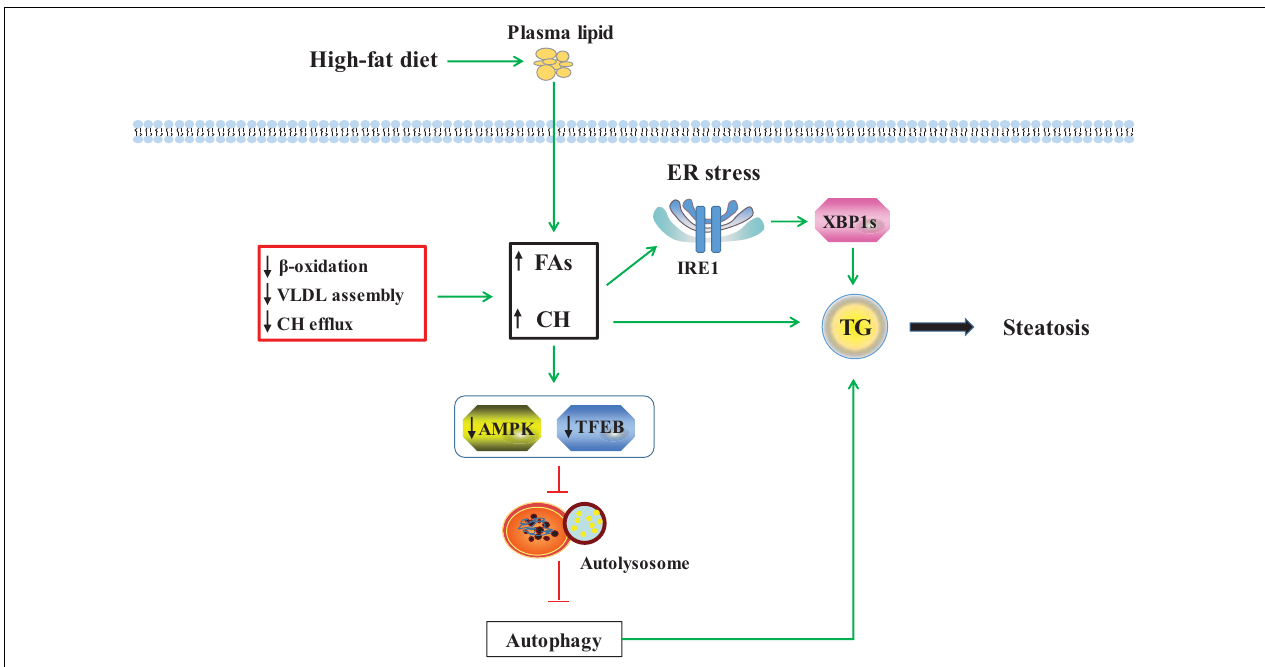
FIGURE 9 | Possible mechanisms of lipotoxicity induced by HFD in tilapia. HFD feeding increased fatty acids (FAs) and free CH (cholesterol) via uptake from plasma. Meanwhile, suppression of FAs β -oxidation, VLDL assembly and CH efflux induced by HFD feeding also enhanced the hepatic FAs and CH content. Increased FAs and CH promoted TG formation which induced hepatic steatosis. Excessive FFA and free CH could cause ER stress and further accelerated steatosis by IRE1-XBP1s signaling pathway. In HFD-induced fatty liver, the decreased AMPK pathway inhibited formation of UKL1 and Atg13 complex, hampered autophagy proteins expression, and ultimately resulted in low autophagy. Moreover, the low autophagy was related to depressed lysosomal biogenesis mediated by TFEB pathway. Suppressed autophagy blocked decomposition of lipid droplets and worsened steatosis.